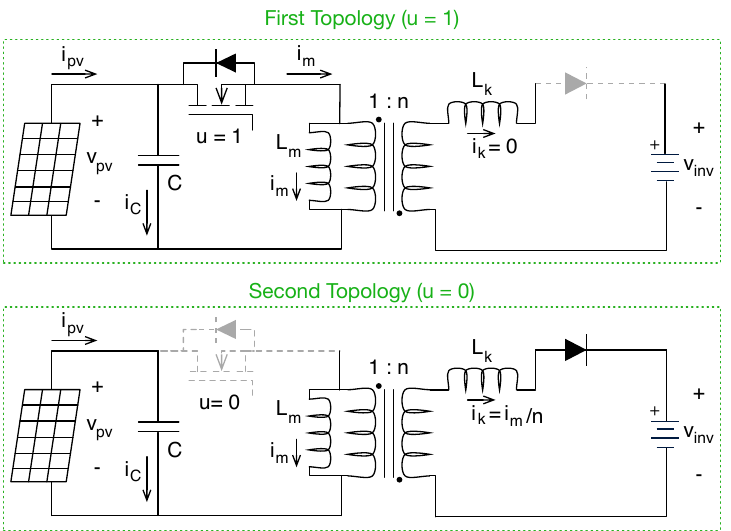
Figure 3. Topologies of the flyback-based PV